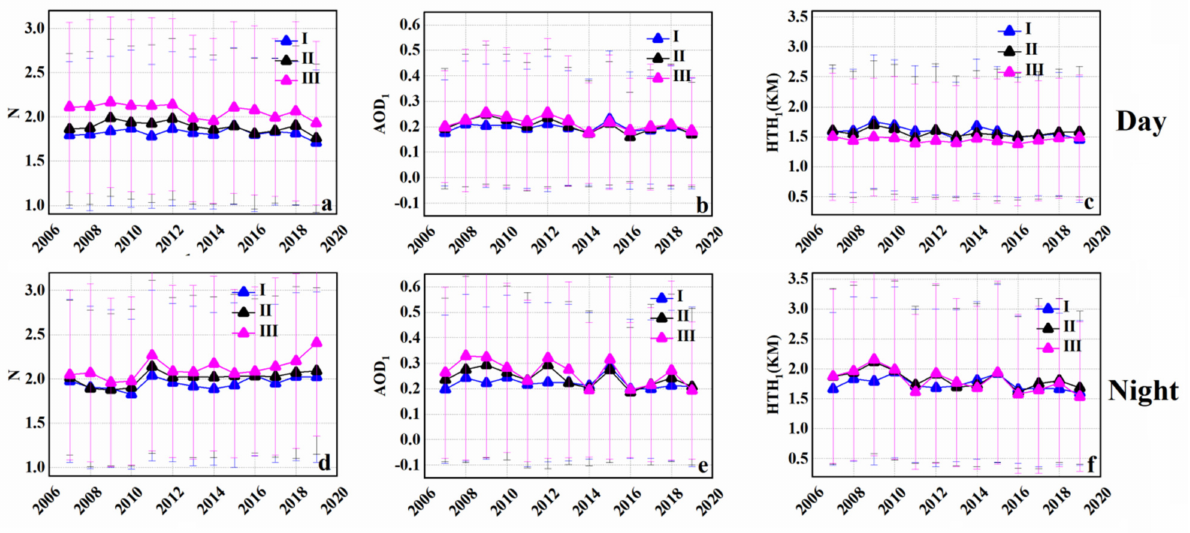
Figure 3. Interannual variations of aerosol layers over Saudi Arabia (region I, region II, and region III) from 2007 to 2019. ( a , d ) The number of aerosol feature layers (N), ( b , e ) the AOD of the